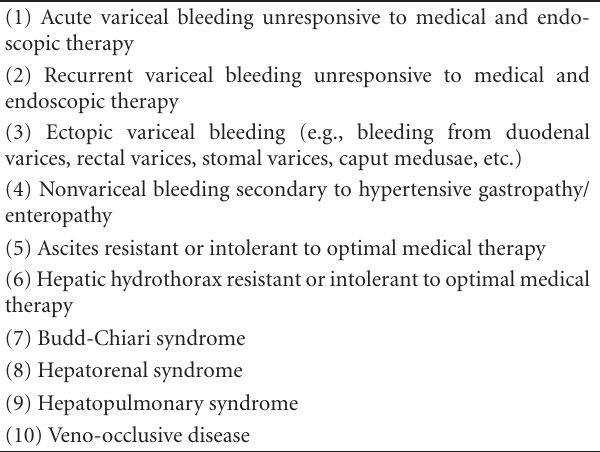
Table 1: Indications for